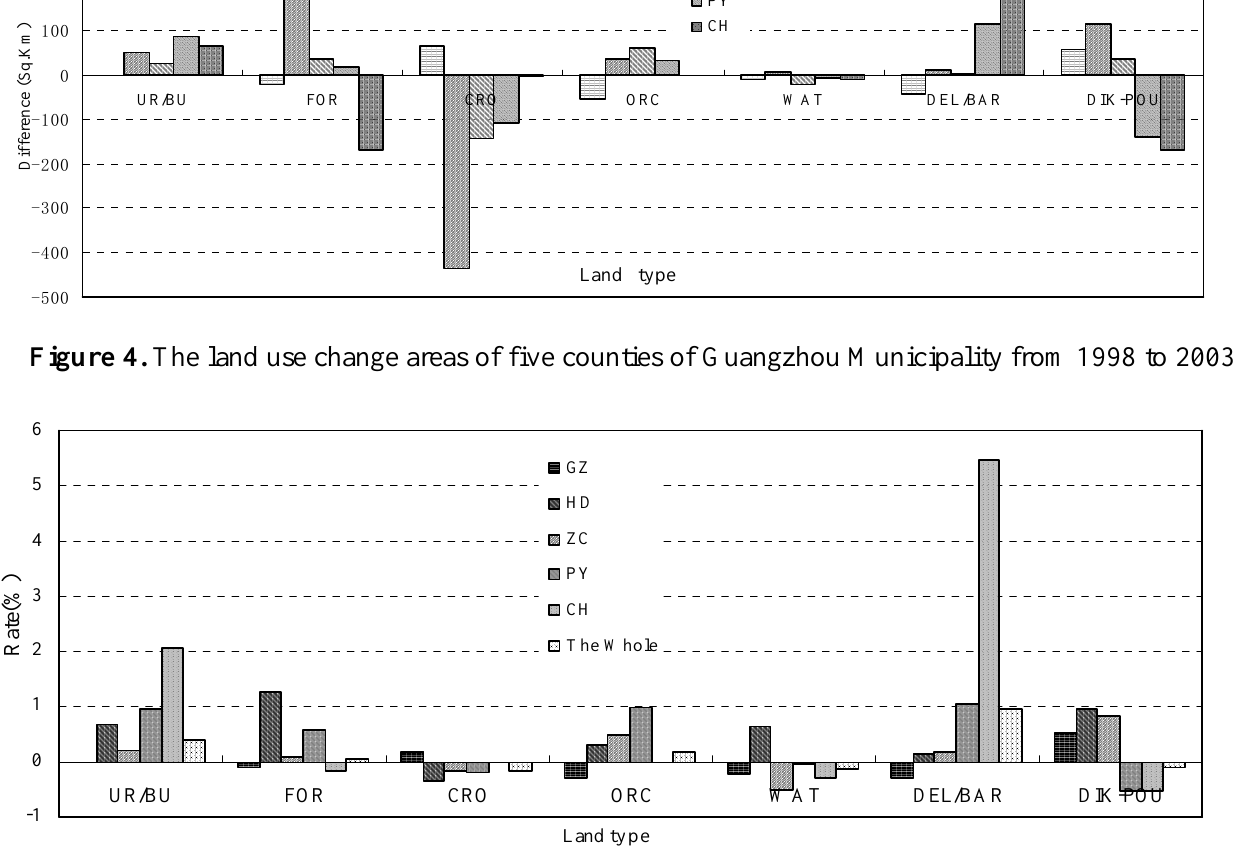
Figure 5. The annual change rates of land use in five cities and the whole Guangzhou Municipality.